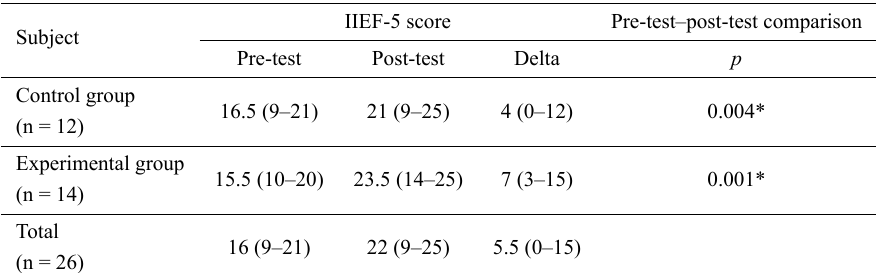
Table 2. Comparison of IIEF-5